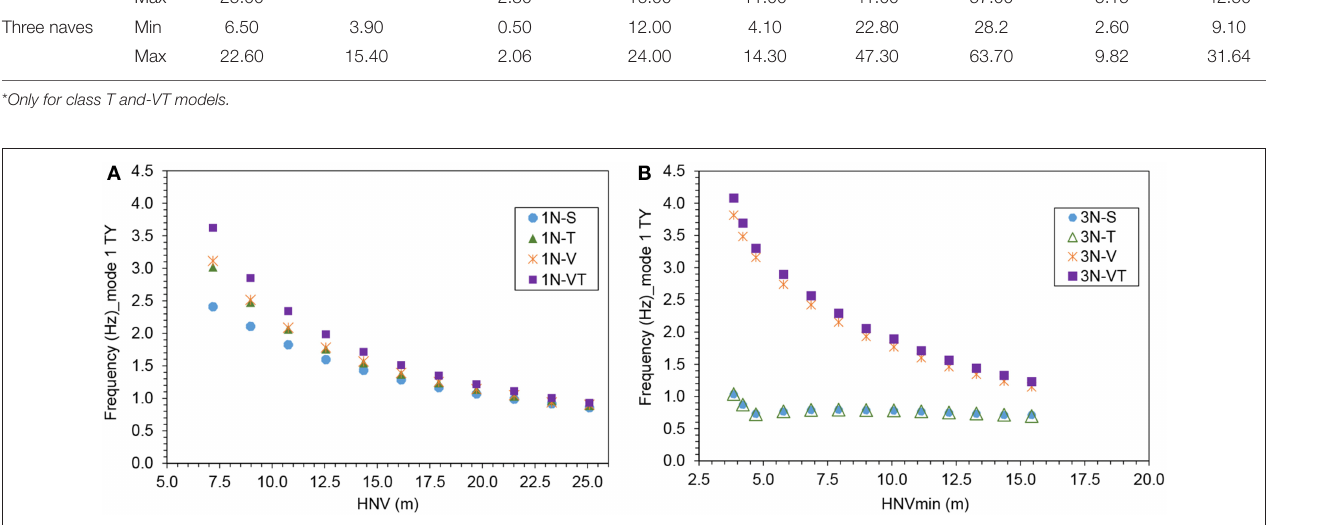
FIGURE 4 | First transversal frequency Mode 1_TY : (A) single nave and (B) three naves churches models.